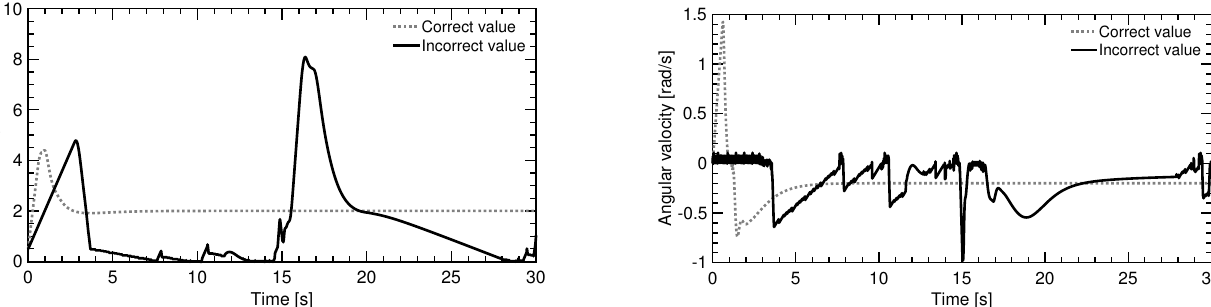
Figure 25. Trajectory following test in case of incorrect tractive force estimation: velocity V ( left ) and rotational velocity ω ( right